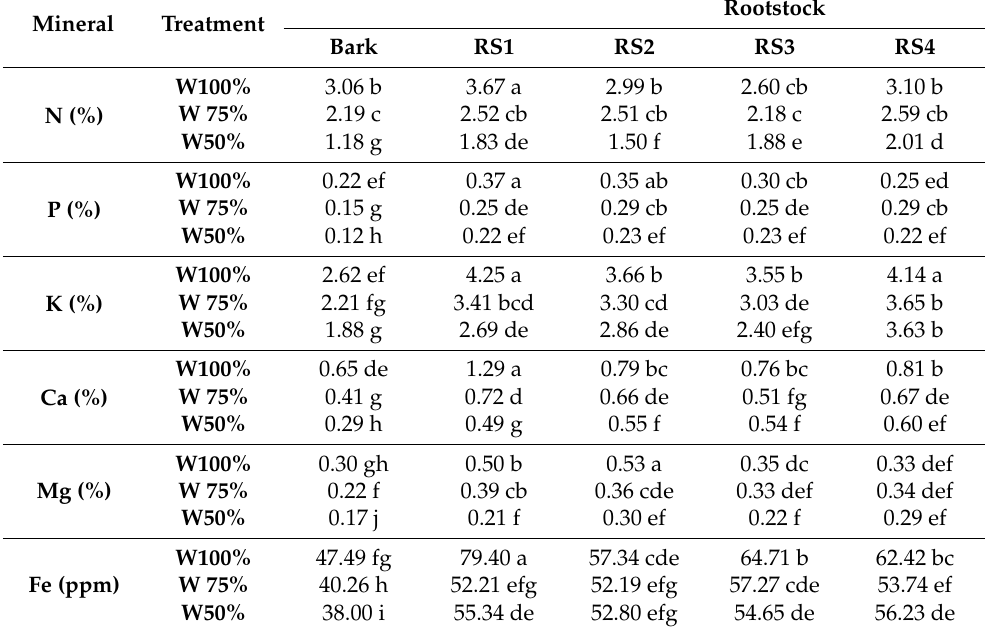
Table 6. Effect of interaction between drought treatments and rootstock on the minerals content of the tomato shoots.